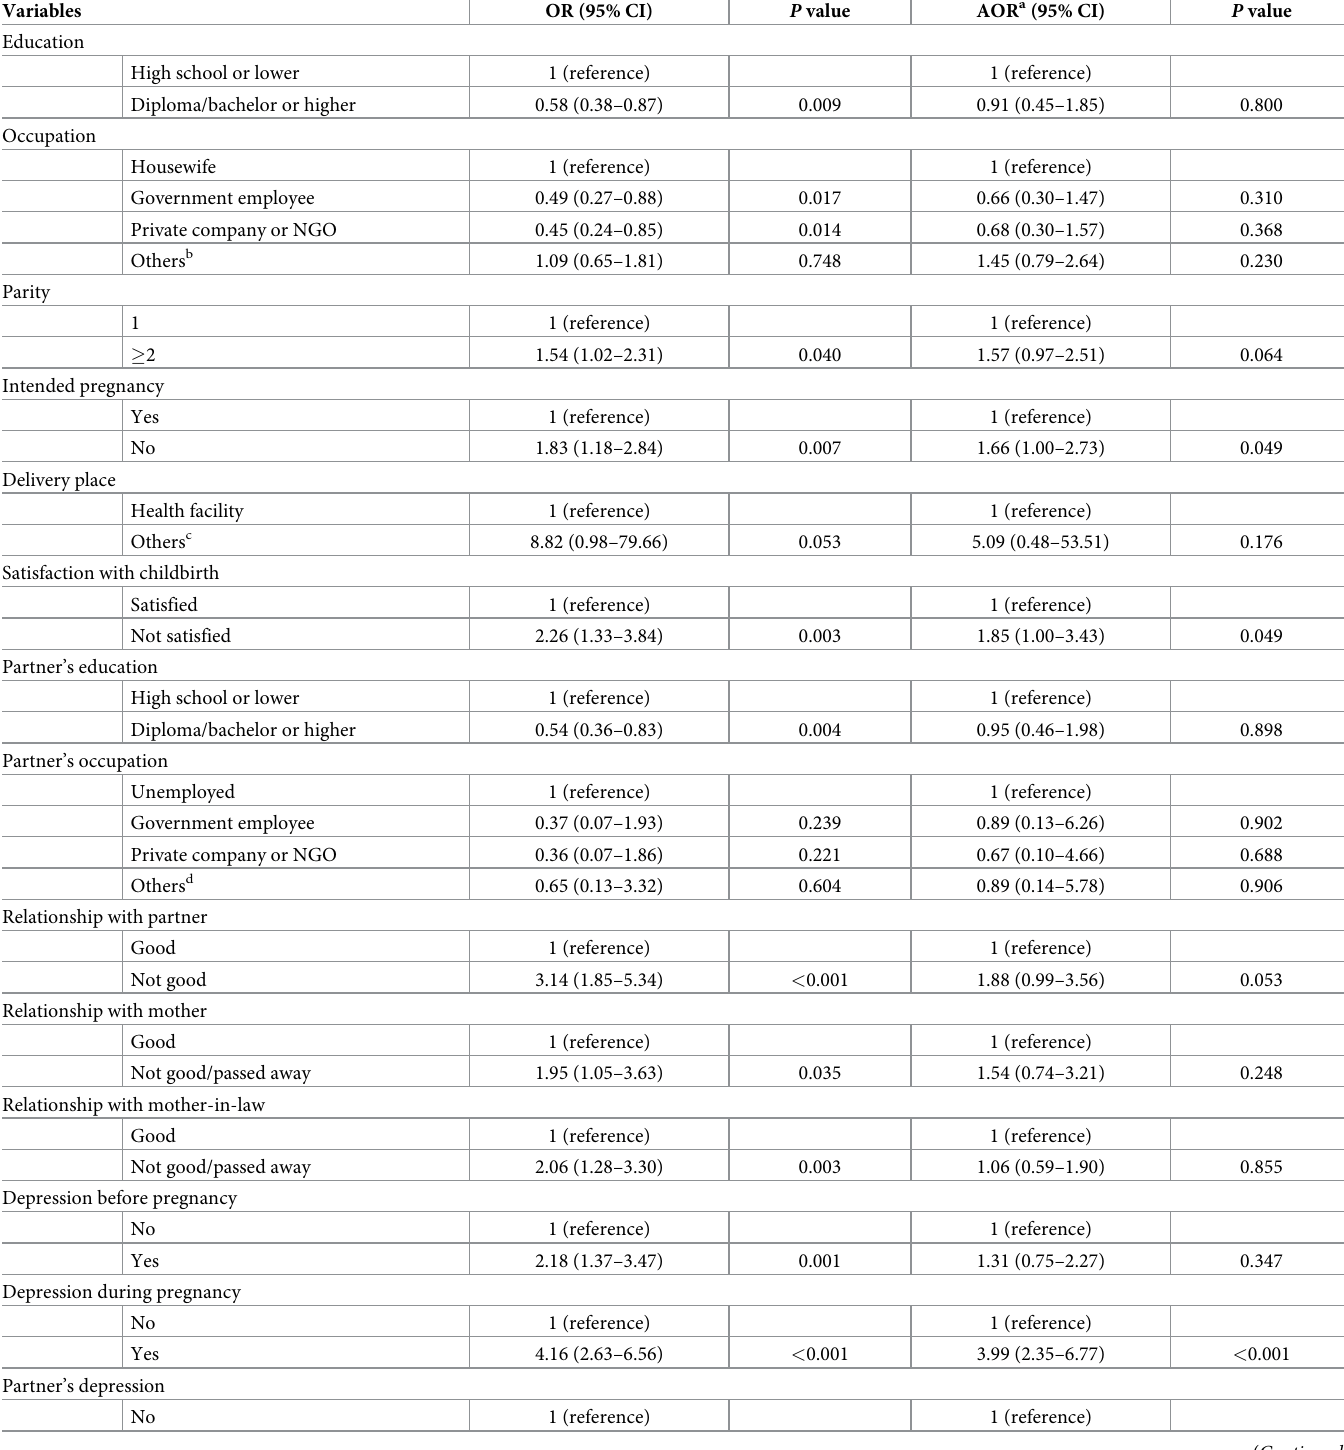
Table 5. Multiple logistic regression on factors associated with suspected postpartum